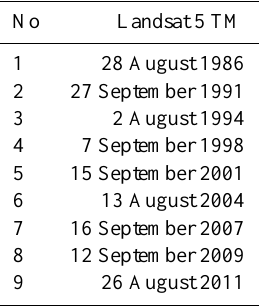
Table A1. Dates of acquisition of Landsat 5 scenes used in this